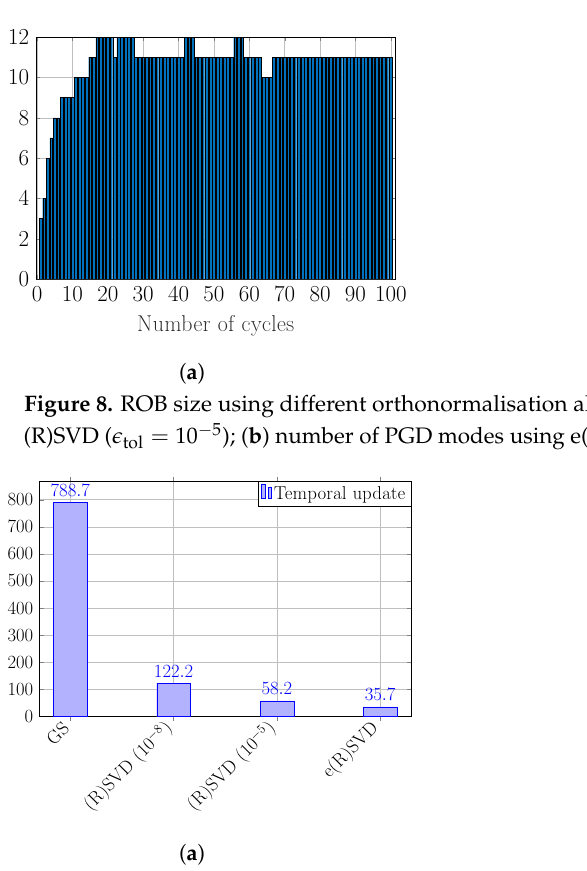
Figure 9. The required time to perform the temporal update and the orthonormalisation steps. ( a ) timing of the temporal functions update; ( b ) timing of orthonormalisation